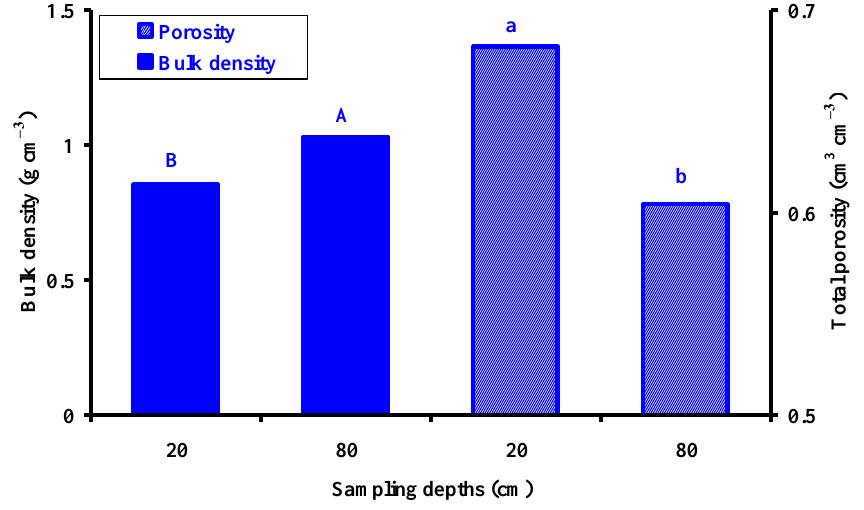
Figure 2. Effect of sampling depths on bulk density and total porosity of soil samples collected from 20 and 80 cm soil depths. Tukey’s mean separation results are shown by the different letters, i.e. , the two groups with two different letters were statistically different.